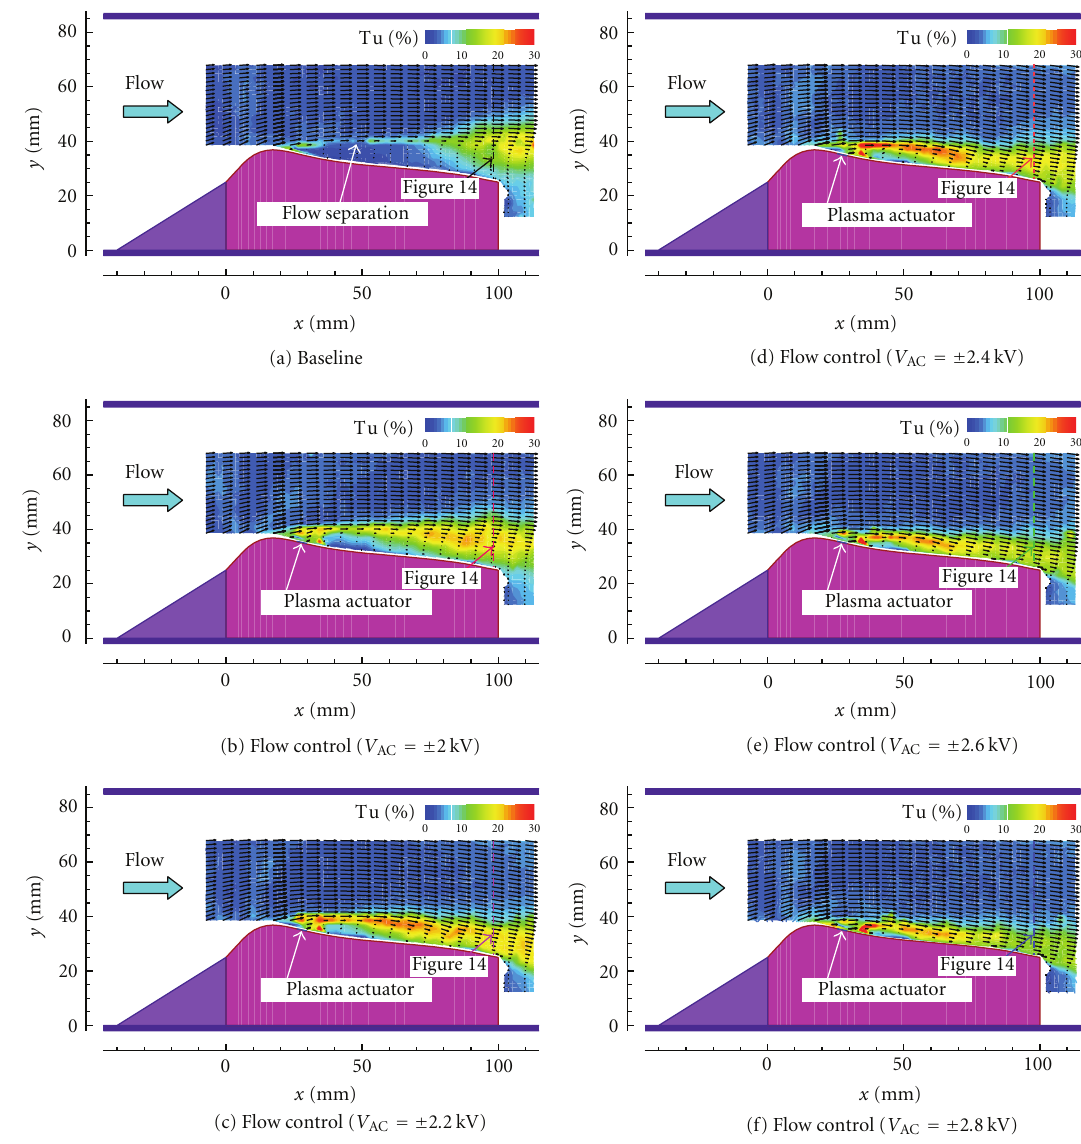
Figure 8: Turbulence intensity distributions at various DBD-PA input